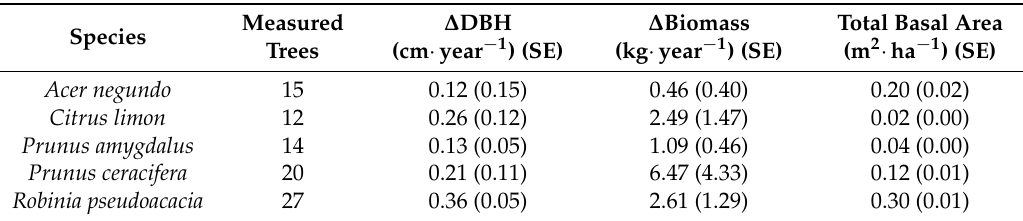
Table 5. Growth diameter rate ( ∆ DBH), change in biomass ( ∆ Biomass) and basal area for the five most frequent tree species in Santiago, Chile during 2002 to